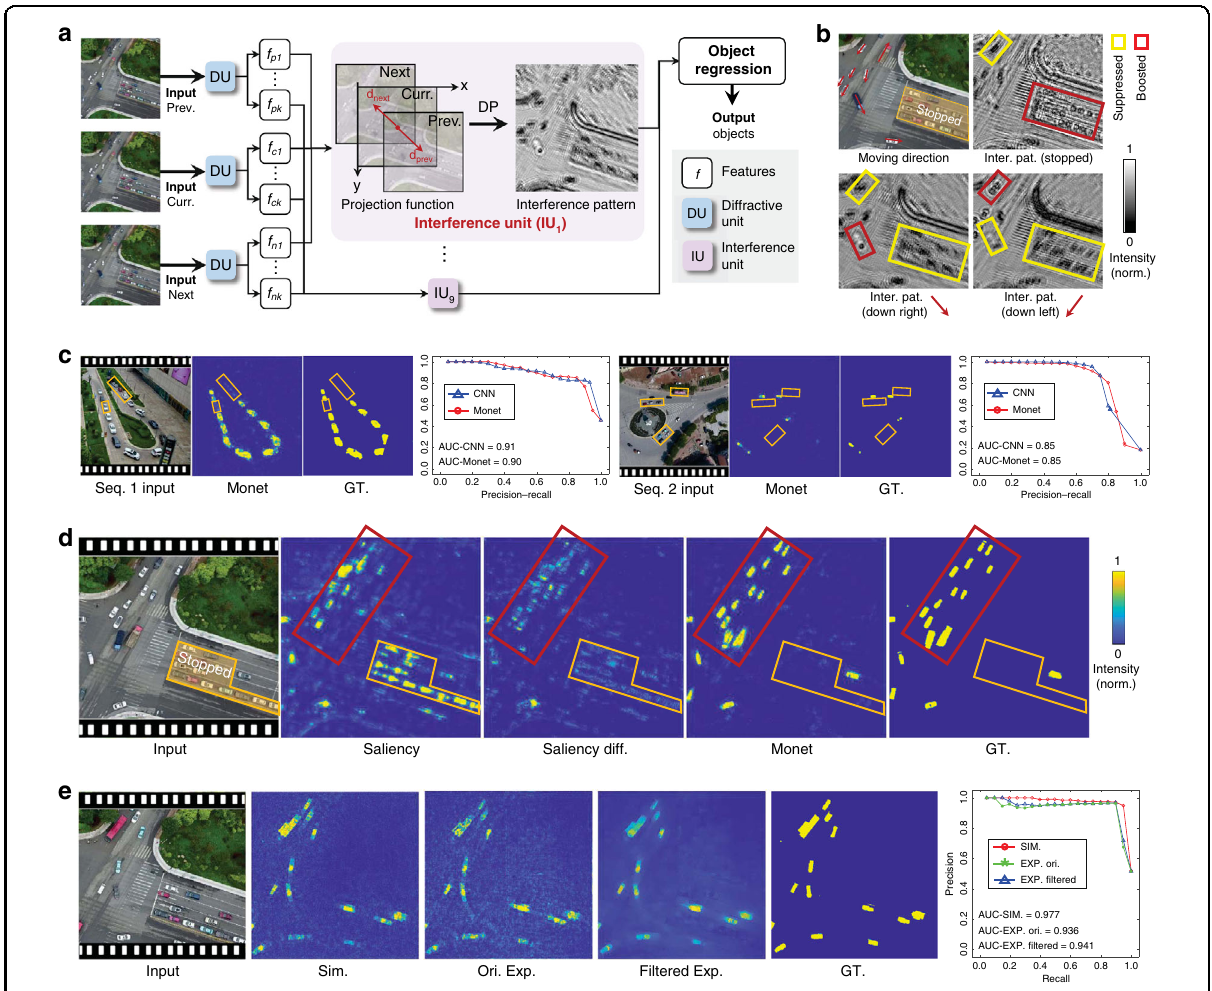
Fig. 3 Moving object detection results. a Network architecture and the projection function of the Monet for moving object detection. The previous frame, current frame and next frame are used as three inputs of Monet. The previous frame and next frame are shifted d prev and d next pixels, and the current frame is fi xed in the projection function. b Interference patterns of a representative frame. The objects are boosted when the projection direction is close to the ground-truth moving direction (labelled with red boxes), while the objects with orthogonal moving directions are suppressed (labelled with yellow boxes). c The input sequences, Monet computational outputs and ground-truth of two representative sequences. The stopped objects are labelled using orange boxes, which are successfully suppressed. Object-level precision-recall (PR) curves and the areas under the curves (AUCs) of each sequence are also presented. An electronic CNN is used for comparison. Note that the moving objects are highlighted in the outputs of Monet, showing very high similarity with the GT. d Comparison results between Monet and the existing optoelectronic saliency detection approach 51 . Saliency diff. shows the difference of the next-frame and the previous-frame saliency maps. e The input sequence, Monet simulation results, original and bilateral fi ltered physical experimental results, and ground-truth of a representative frame in the test sequences. The object-level PR curve and AUC are illustrated on the right. The outputs of Monet simulation and optical Monet experiments show a high correlation in the fi nal distribution. The optical output shows acceptable performance loss compared with simulations. With a simple bilateral solver applied in the fi nal results, the speckles are removed for better visualization. Prev previous, Curr current, Seq sequence, Inter interference, Pat pattern, Norm normalized, GT ground-truth, Sim simulation, Ori original, Exp experimental, Diff difference, DP diffractive